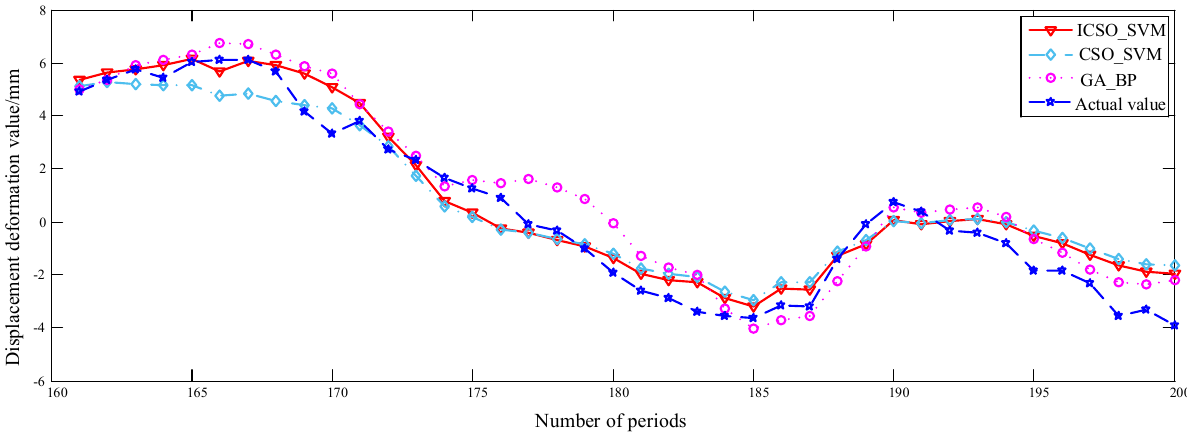
Figure 13. Horizontal displacement prediction curves of three model dam test samples. As can be seen from Figure 14, the prediction curve of the ICSO-SVM model follows the measured value curve best. Compared with the CSO-SVM model, the prediction accuracy of the ICSO-SVM model is significantly higher than that of the CSO-SVM model in the period 161–175, and then, the prediction accuracy of the two models is comparable in the period 176–200. Compared with the GA-BP model, the prediction of the GA-BP model is more volatile, while the prediction of the ICSO-SVM model is more stable. The prediction error curves of the three dam horizontal displacement prediction models are shown in Figure 14.